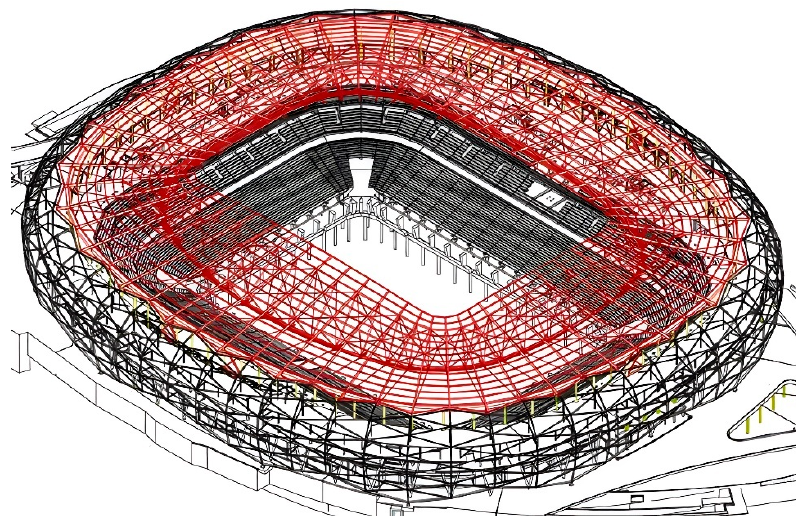
Figure 2. Integral 3D axonometric drawing.